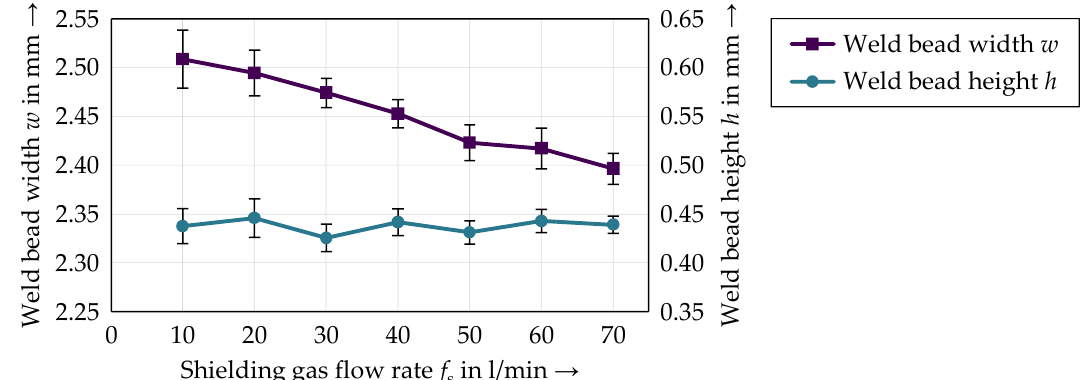
Figure 9. Influence of the shielding gas flow rate when using the optimized nozzle on the weld bead width w and the weld bead height h ; the error bars show the respective standard deviation. perature was monitored during the process using an in-axis pyrometer. The temperature data of the first 25 mm and the last 8 mm of the weld beads were omitted, so that only